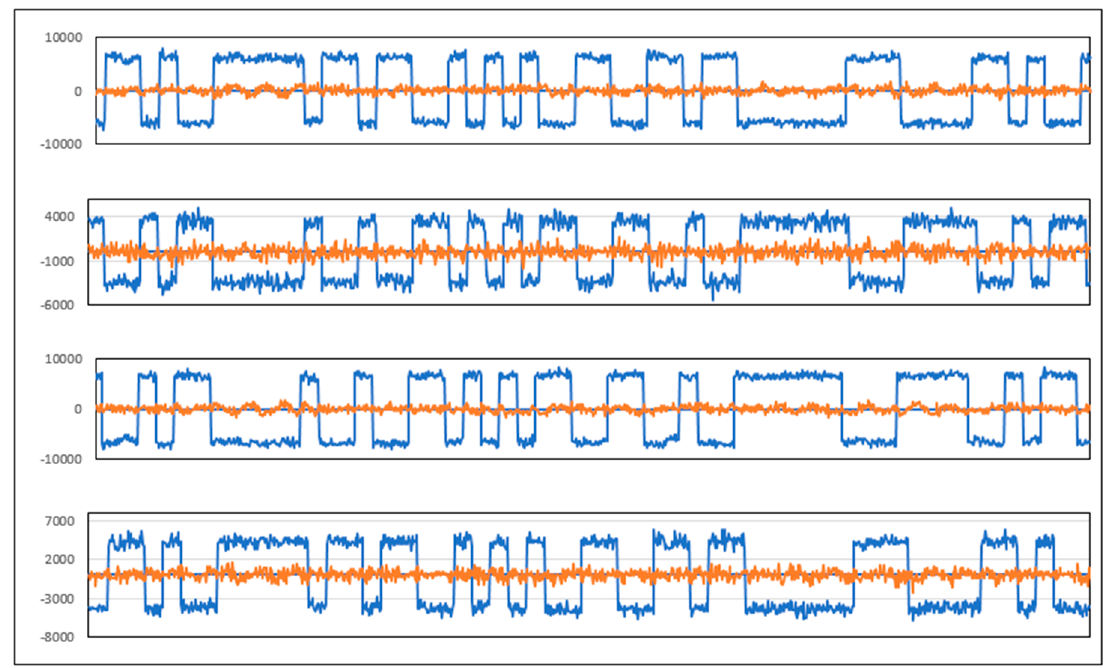
Figure 16. Prompt in-phase (blue) and quadrature (red) tracking results (for 1 s) of GPS C/A (coarse acquisition signal) multi-channel processing of real data using GNSS-ISE (SV12, SV15, SV24, SV32). Tracking is performed with 1 ms integration time, 20 ms per GPS C/A.